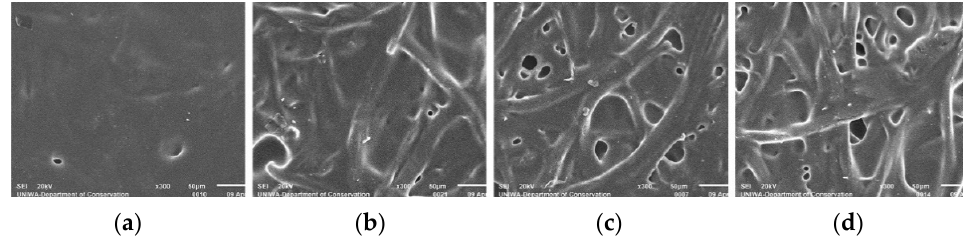
Figure 7. SEM images of cotton mock-ups impregnated with stand-oil at different stages of ageing,